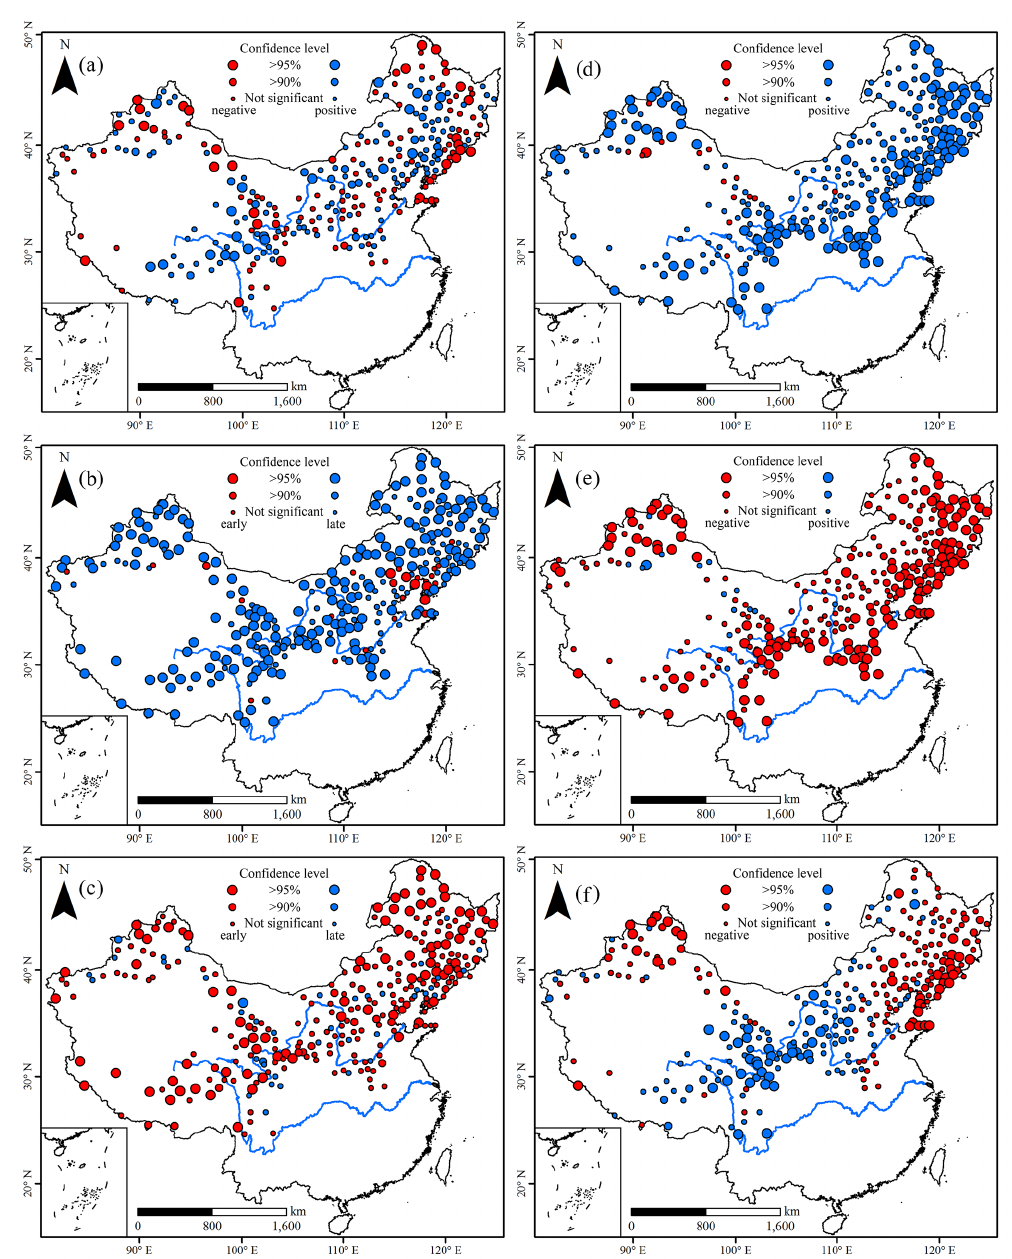
Figure 6. Significance of trends according to the Mann–Kendall test of SCDs (a) , SCOD (b) , and SCED (c) from the 296 stations with more than 10 annual mean SCDs, significance of relationship between the SCDs and days with temperature below 0 ◦ C (TBZD) (d) , significance of relationship between the SCDs and mean air temperature (MAT) (e) , and significance of relationship between the SCDs and Arctic Oscillation (AO) index (f)